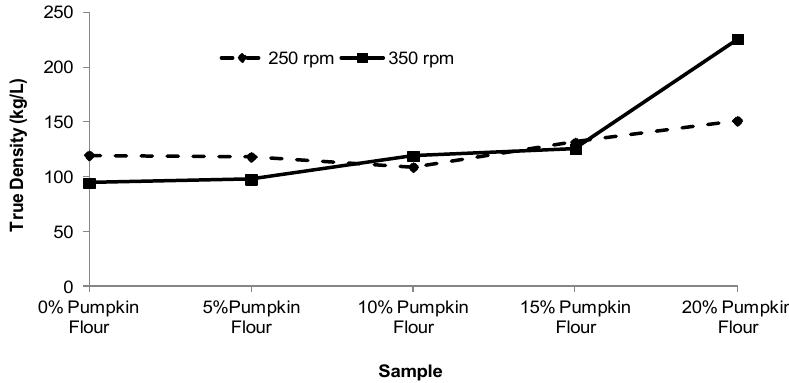
Figure 7. Effect of varying pumpkin flour percentage and screw speed on the true density of extruded product. Each value was an average of duplicate samples.